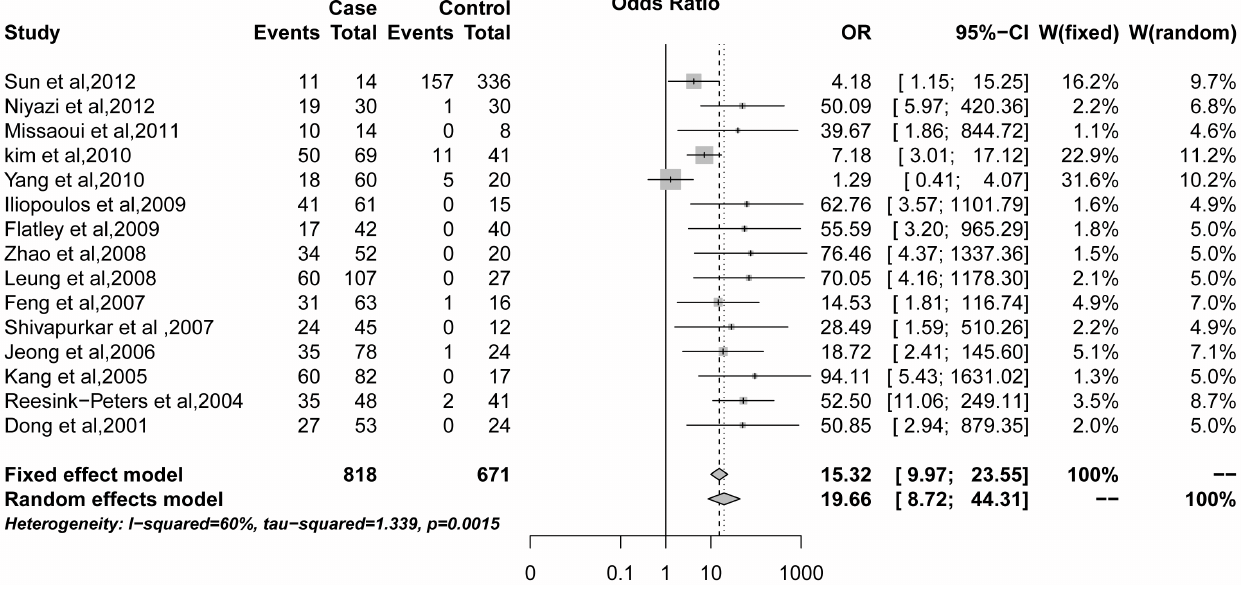
Table 3. Meta-regression analysis on 15 selected studies (Table 1).